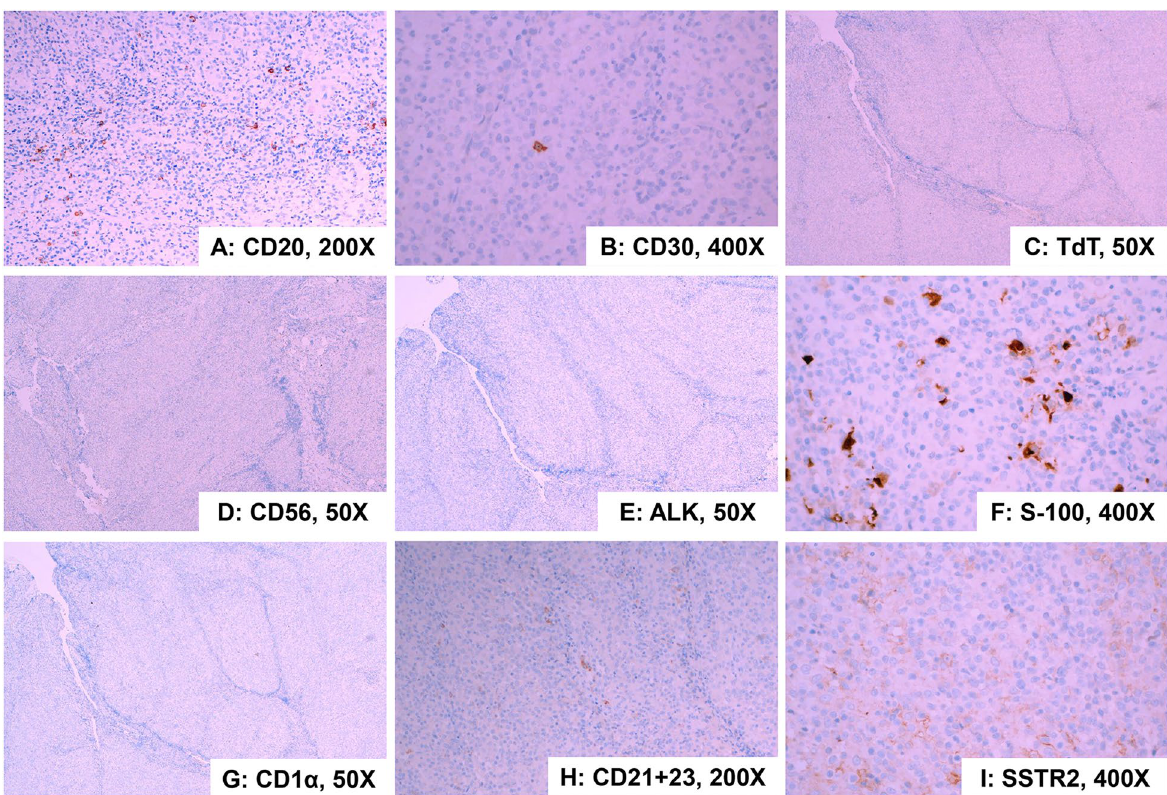
Fig. 4 Immunohistochemical findings for other negative antibodies. Immunohistochemical stains for CD20, CD30, TdT, CD56, ALK, S-100, CD1α, CD21 23, and SSTR2 are negative. ( A CD20, 200 + 200 ; I SSTR2, 400 × ×